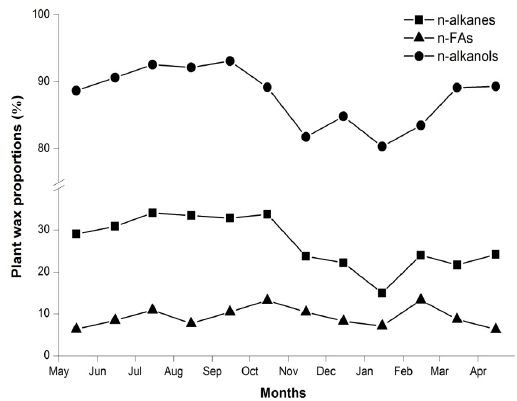
Figure 6. Temporal variations in plant wax contributions (ratios between concentration of plant wax lipids relative to that of total lipids) of different types of lipids ( n -alkanes: square; n -FAs: triangle; n -alkanols: cycle) in south coastal Xiamen. Wax in n -FAs and n -alkanols is the sum of ≥ C 22 homologs. Wax in n -alkanes is the sum of ≥ C 27 homologs corrected for fossil source contribution.